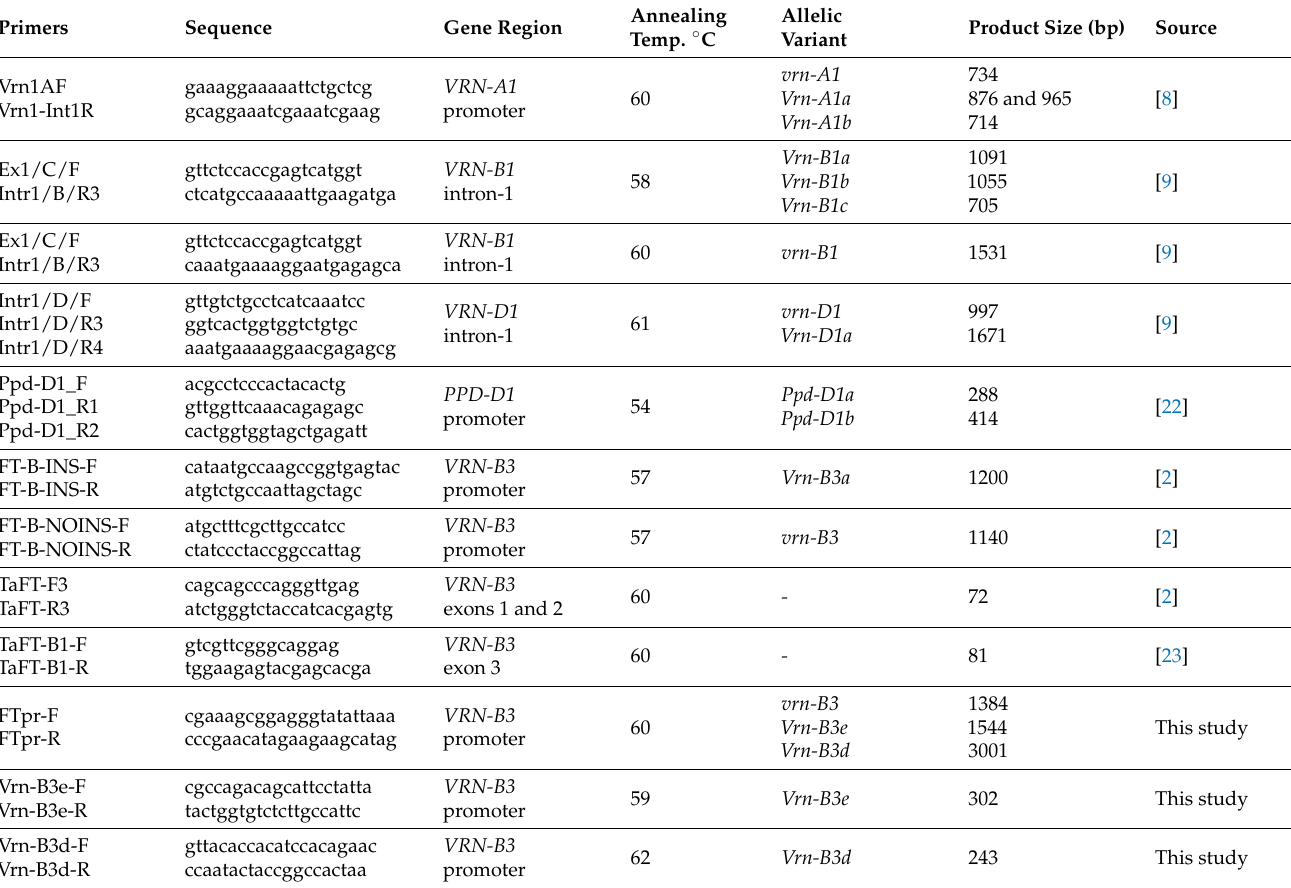
primers, DNA at a concentration of 5 ng/ µ L, and sterile water. Table 1. Primer sequences, annealing temperatures, and expected PCR product